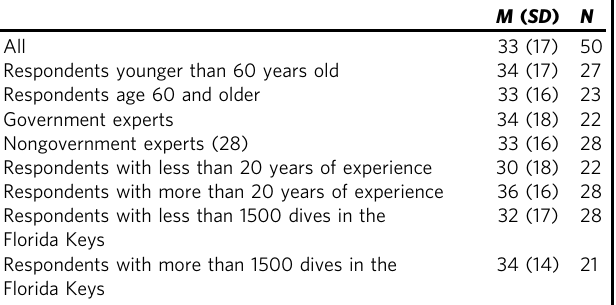
Table 3 Mean (standard deviation) cover percentage baselines among various respondent types. For the Florida Keys, what should the baseline cover percentage for stony corals be (on average throughout the keys, bank reef, and buttress zone at a depth of 10 m)?